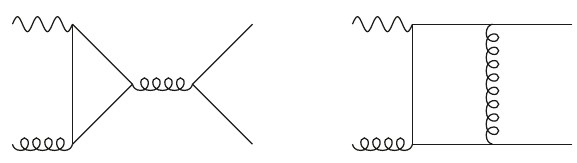
Figure 1 . Example of Feynman diagrams for singlet (left) and non-singlet (right) contributions.